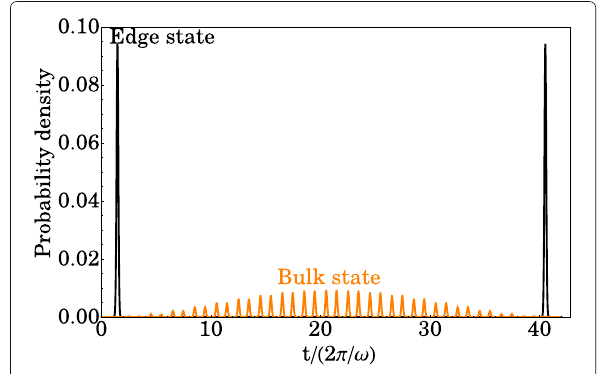
Fig. 4 A particle driven resonantly in time so that the effective Hamiltonian H eff , Eq. (2), reproduces the topological Su-Schrieffer-Heeger model with an edge [80, 81]. There are two kinds of eigenstates of H eff : bulk states and topologically protected edge states. In the laboratory frame, the bulk states are delocalized along the entire resonant orbit while the edge states are localized close to the edge which appears periodically in time. The case of a 42 : 1 resonance is presented in the plot. Reprinted from [35]